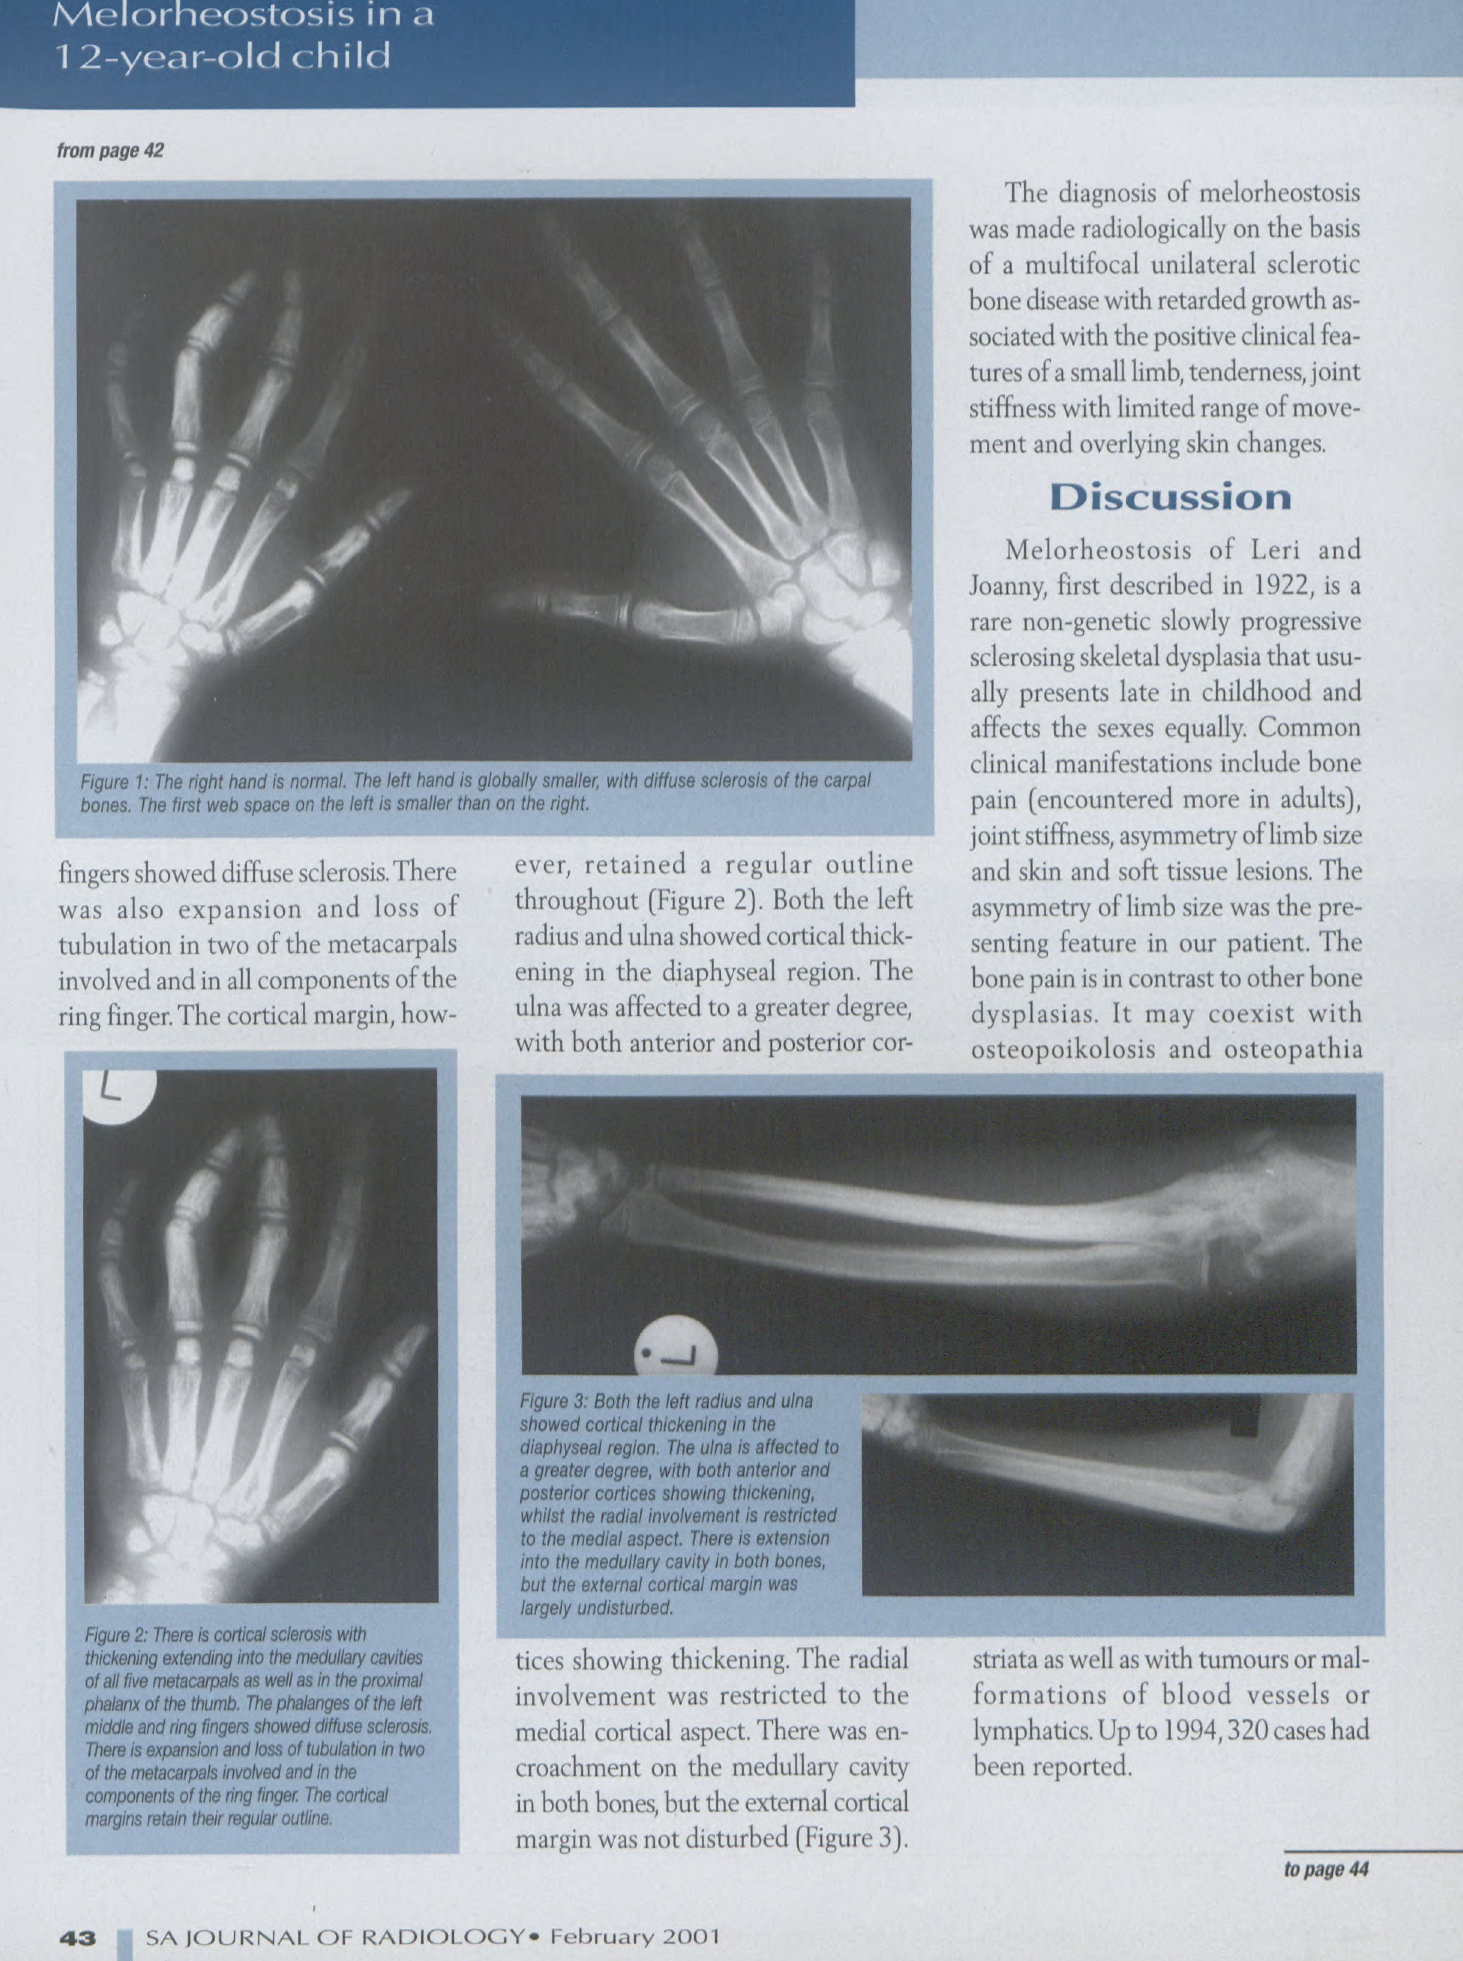
Figure 2: There is cortical sclerosis with thickening extending into the medullary cavities of all five metacarpals as well es in the proximal phalanx of the thumb. Thephalanges of the left middle and ring fingers showed diffuse sclerosis. There Isexpansion and loss of tubulation in two of the metacarpals involved and in the components of the ring finger. Thecortical margins retain their regular outline.